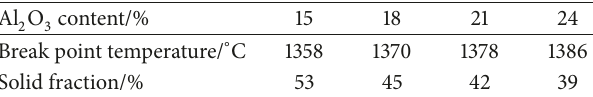
Table 2: Solid fraction at break point